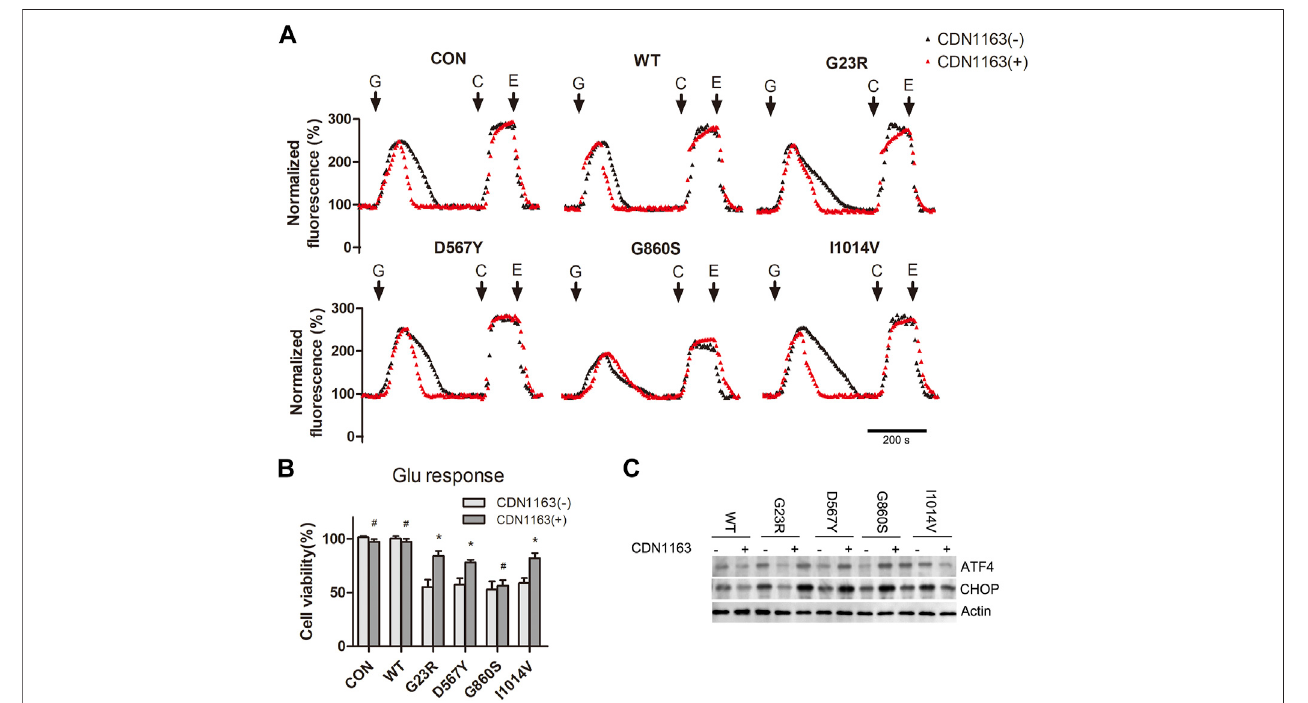
FIGURE 5 | CDN1163 inhibits hypo-glutamate-induced excitotoxicity by reducing SERCA2 mutant-mediated ER Ca 2+ depletion and stress. (A) : Representative normalized fl uorescence of cytoplasmic Ca 2+ by Furo-4 AM. CDN1163 enhanced cytoplasmic Ca 2+ clearance of SERCA2 mutants. The addition of glutamate (G), caffeine (C), EGTA (E) is indicated with black arrows. Scale bar, 200 s. (B) : CDN1163 rescues the cell viability of SERCA2 mutants under hypo-glutamate loading. * p < 0.05compared with no-CDN1163 treatment, # p > 0.05compared with no-CDN1163 treatment. (C) : Low protein level of ERS marker in SERCA2mutants with CDN1163 treatment by Western